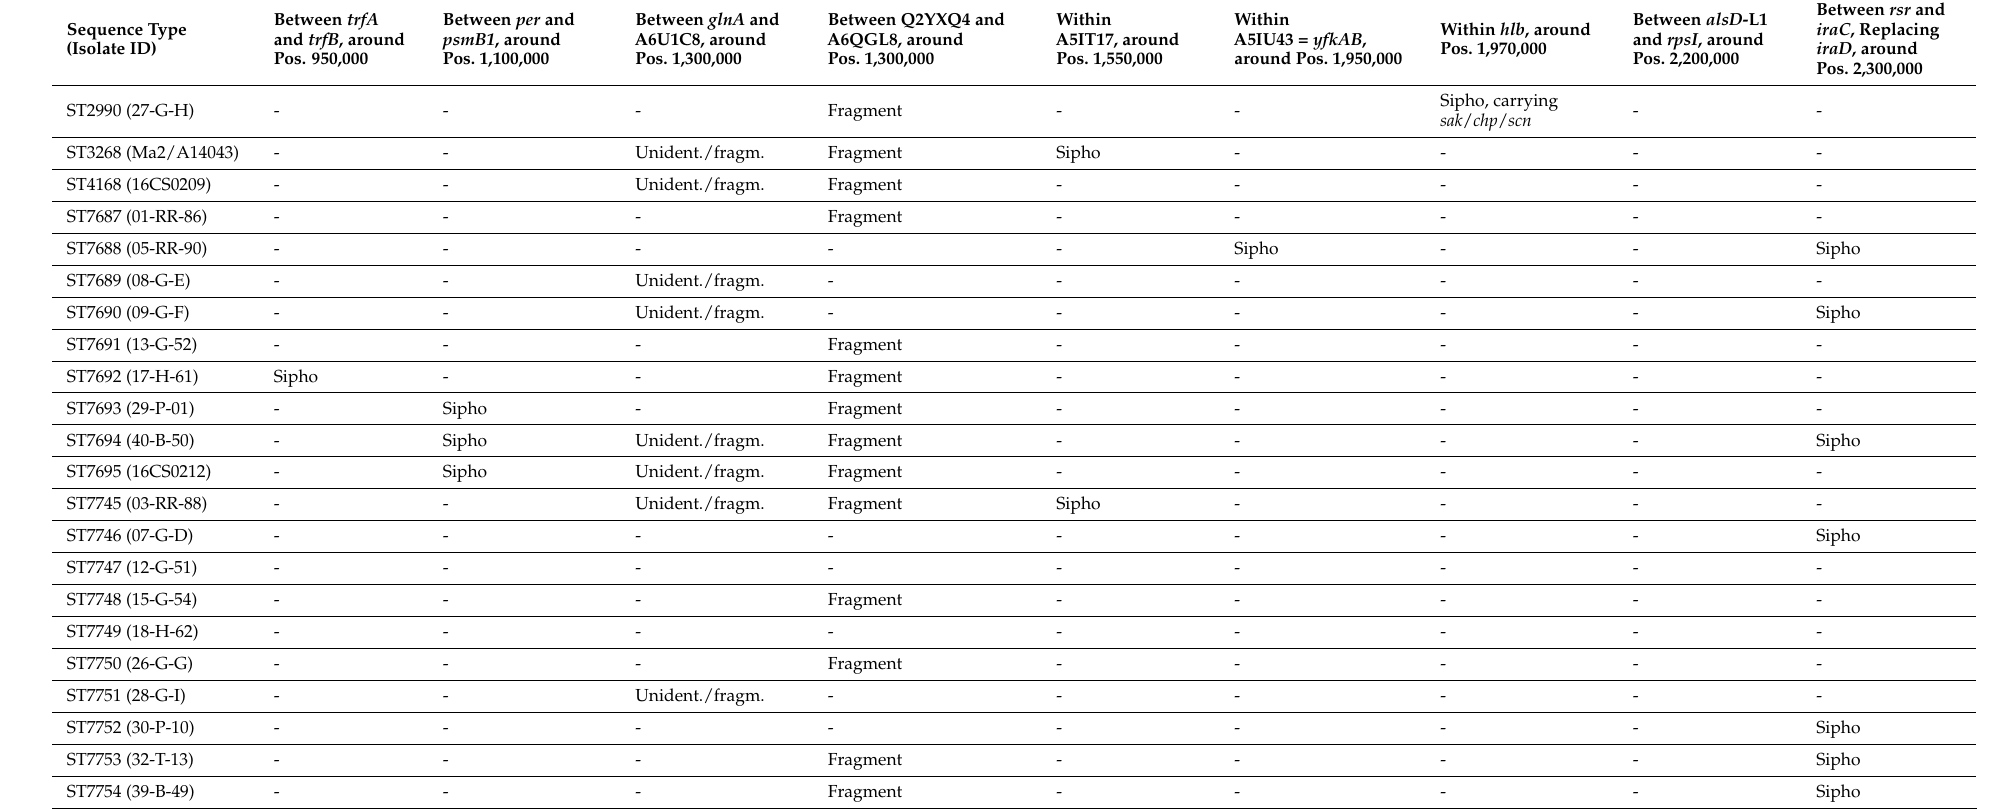
Table 4. Prophages and their integration